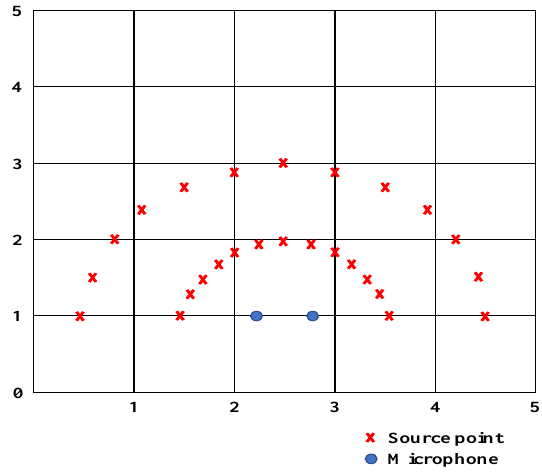
Figure 2. Simulated space configuration diagram.